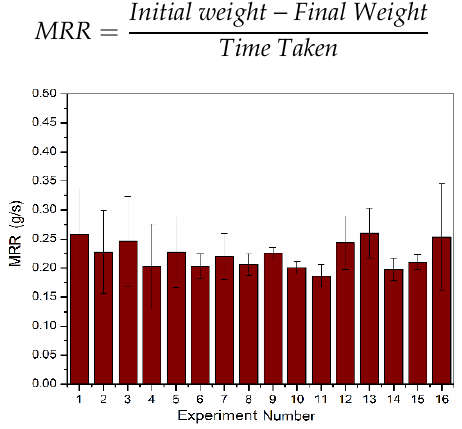
Figure 1. Bar graph of measured average material removal rate (MRR) for each experiment. Error bars show the standard deviation value.